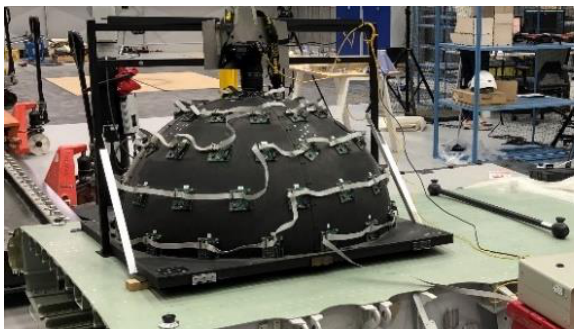
Figure 1. The 0.5m radius UCL illumination dome. Coded targets to characterise and track the dome are visible at the corners of the dome base plate and on the dome